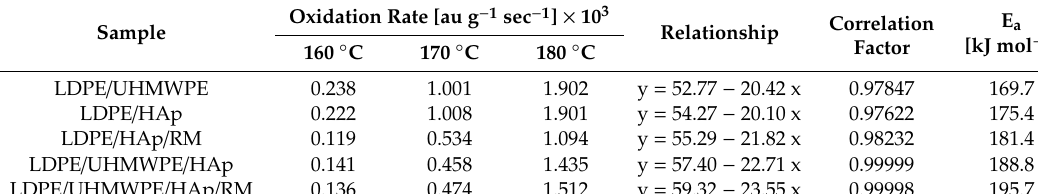
Table 3. Calculated activation energies from isothermal chemiluminescence determinations.